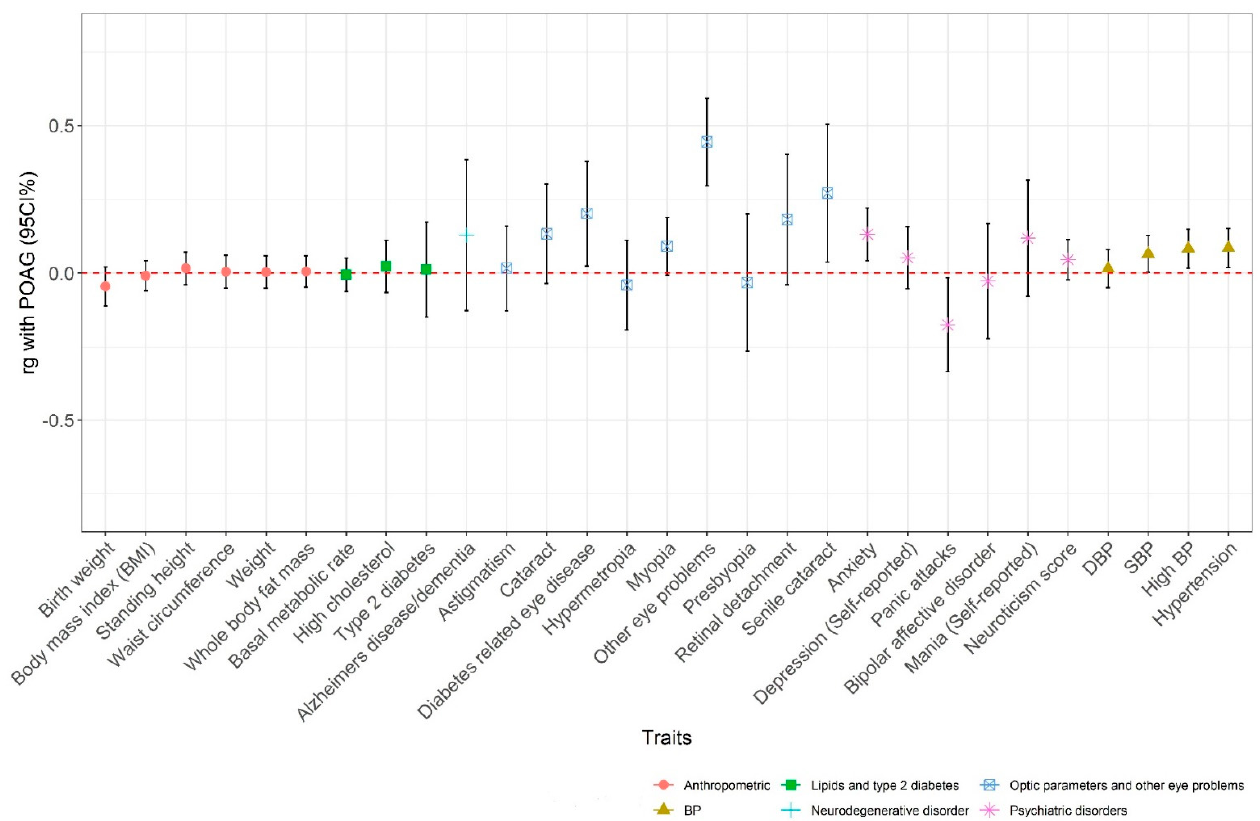
Figure 7. Dot and whisker plot: the genetic correlations and 95% confidence intervals between POAG and six phenotypic categories were calculated using the LD score regression method.